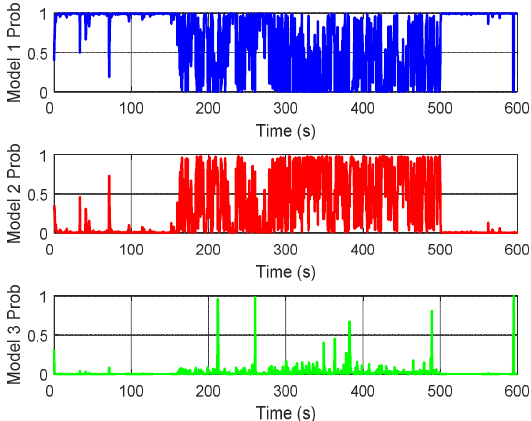
Figure 23. The model probability of the local SINS/DVL system.